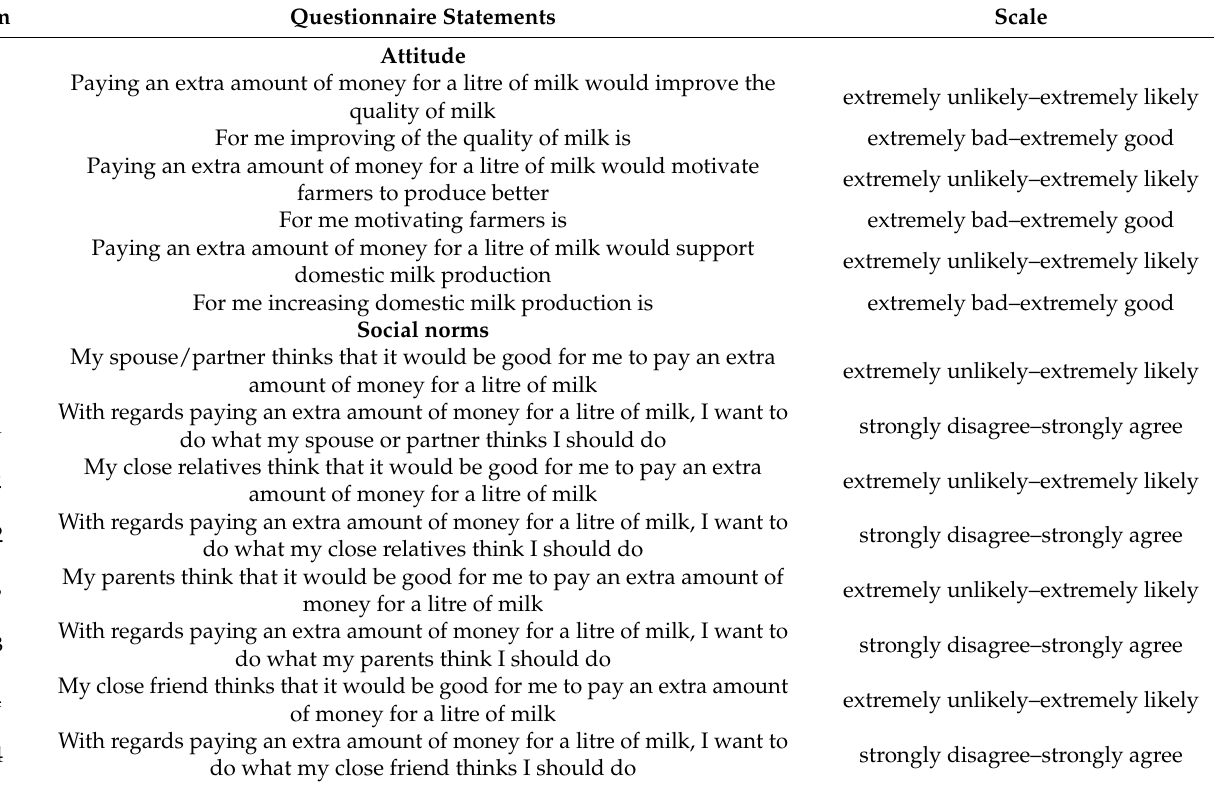
Table 1. Statements to reveal respondent’s attitude, social norms, and perceived behavioural control towards the behaviour.